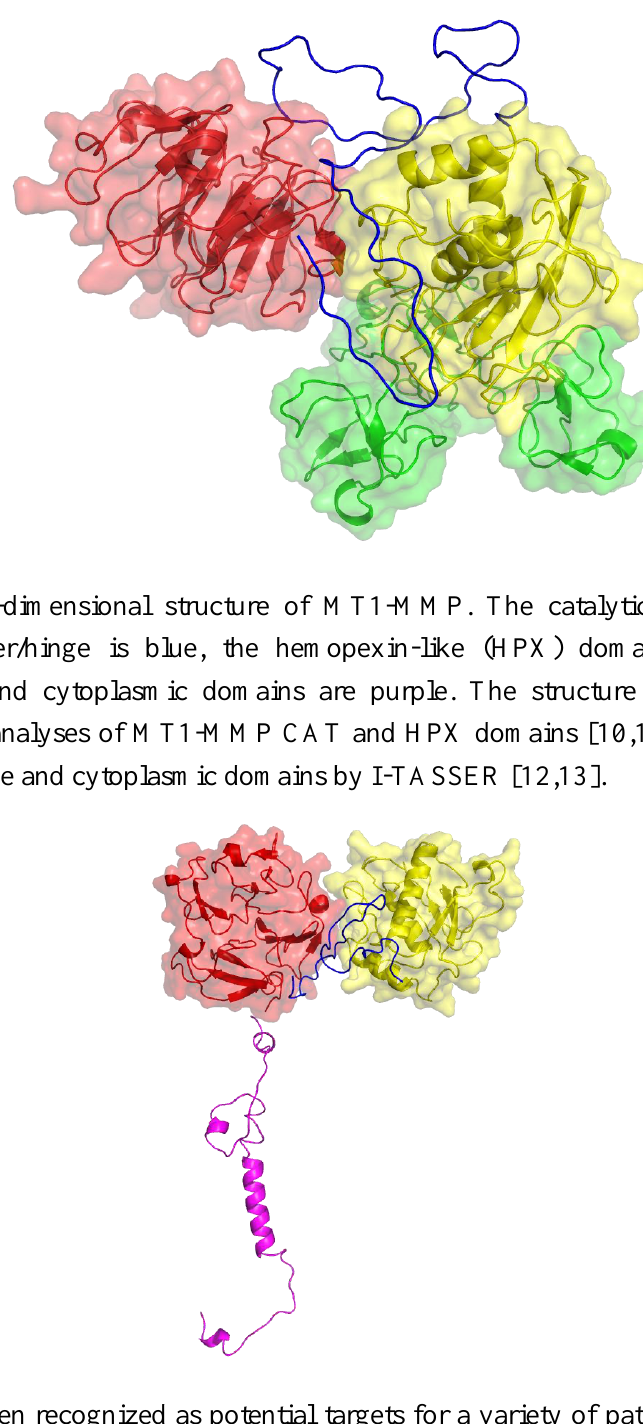
Figure 3. Three-dimensional structure of MMP-9. The catalytic (CAT) domain is yellow, the linker/hinge is blue, the hemopexin-like (HPX) domain is red, and the fibronectin type II [FN(II)] inserts are green. The structure is based on X-ray crystallographic analyses of MMP-9 CAT and HPX domains [8,9].